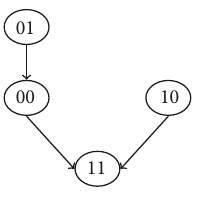
Figure 2: Phase diagram of the